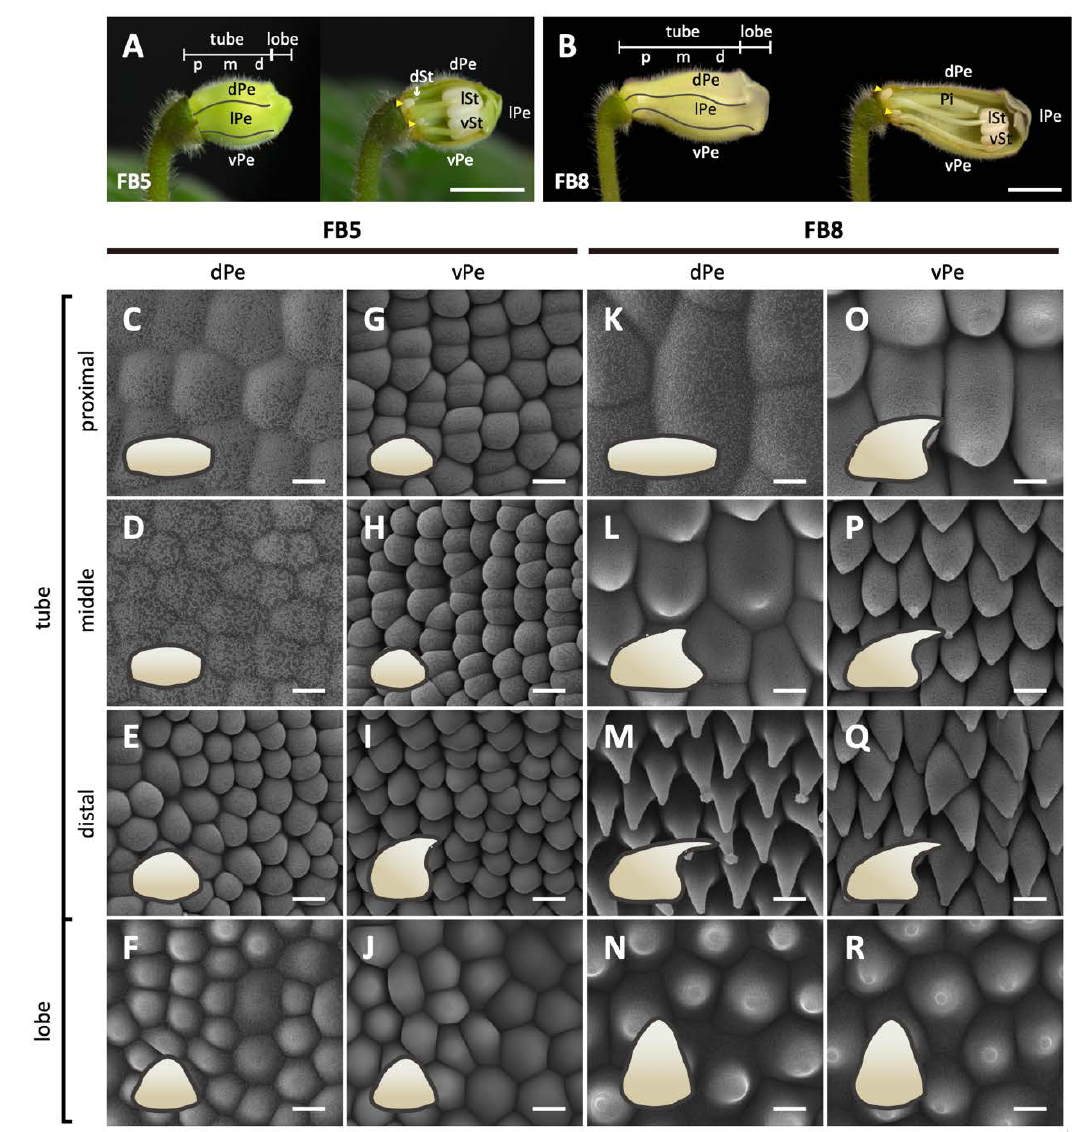
Figure 2. Morphological changes in the epidermal cells of the dorsal and ventral petals of S. speciosa ‘ES’ flowers. ( A , B ) The overview and longitudinal sections of floral buds at stages FB5 and FB8. The white arrow indicates the arrested growth of the dorsal staminode, and the yellow arrowheads show the lateral nectaries. Scale bars = 1 cm. ( C – R ) Top-view Cryo-SEM images of the adaxial epidermis of dorsal and ventral petals. Side-views of epidermal cells are illustrated as cartoon pictures in the bottom-left of each panel. Scale bars = 10 μm. dPe, dorsal petal; lPe, lateral petal; vPe, ventral petal; dSt, dorsal staminode; lSt, lateral stamen; vSt, ventral stamen; Pi, pistil. Different regions of the corolla tube: p, proximal; m, middle; d, distal.